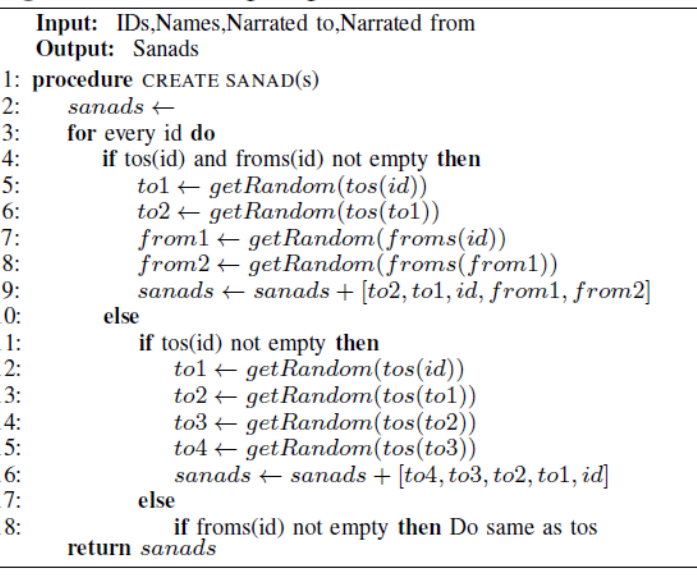
Figure 4. Steps to create sanads of length